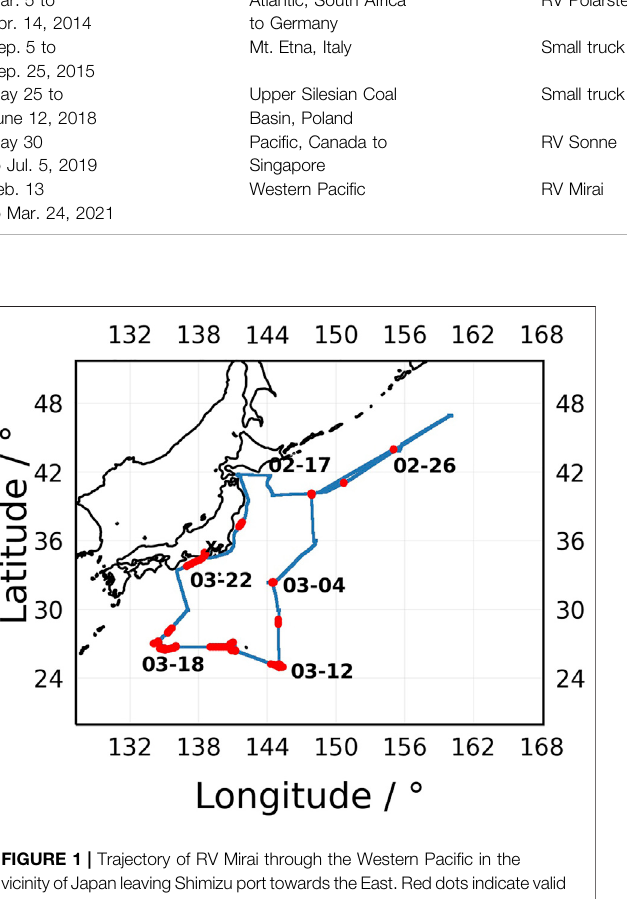
Frontiers in Remote Sensing |